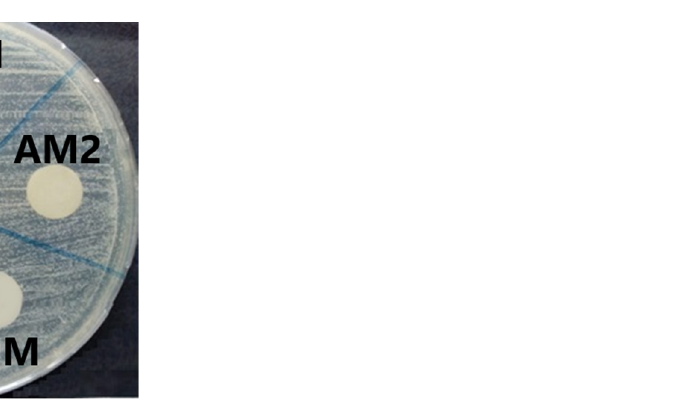
Figure 8. Antibacterial property evaluation for the experimental PMMA bone cements: ( a ) growth inhibition zone for Gram-positive strain Staphylococcus aureus ATCC 2592; ( b ) growth inhibition